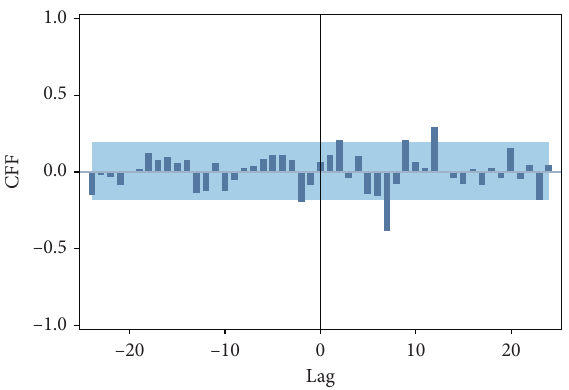
Figure 7: CCF significance test chart of two residual